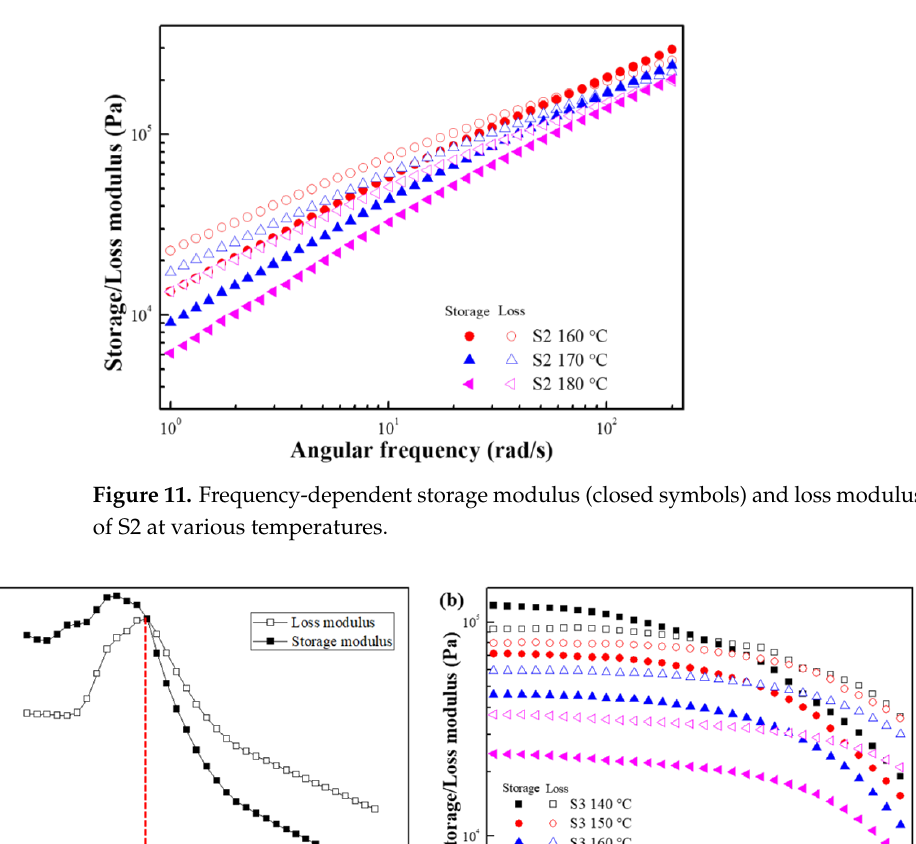
Figure 11. Frequency-dependent storage modulus (closed symbols) and loss modulus (open sym- bols) of S2 at various temperatures.